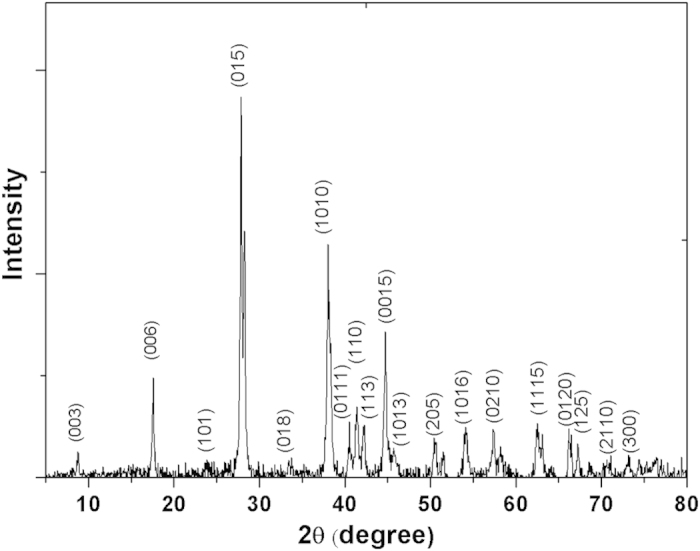
XRD of the Bi2Te3 powders.